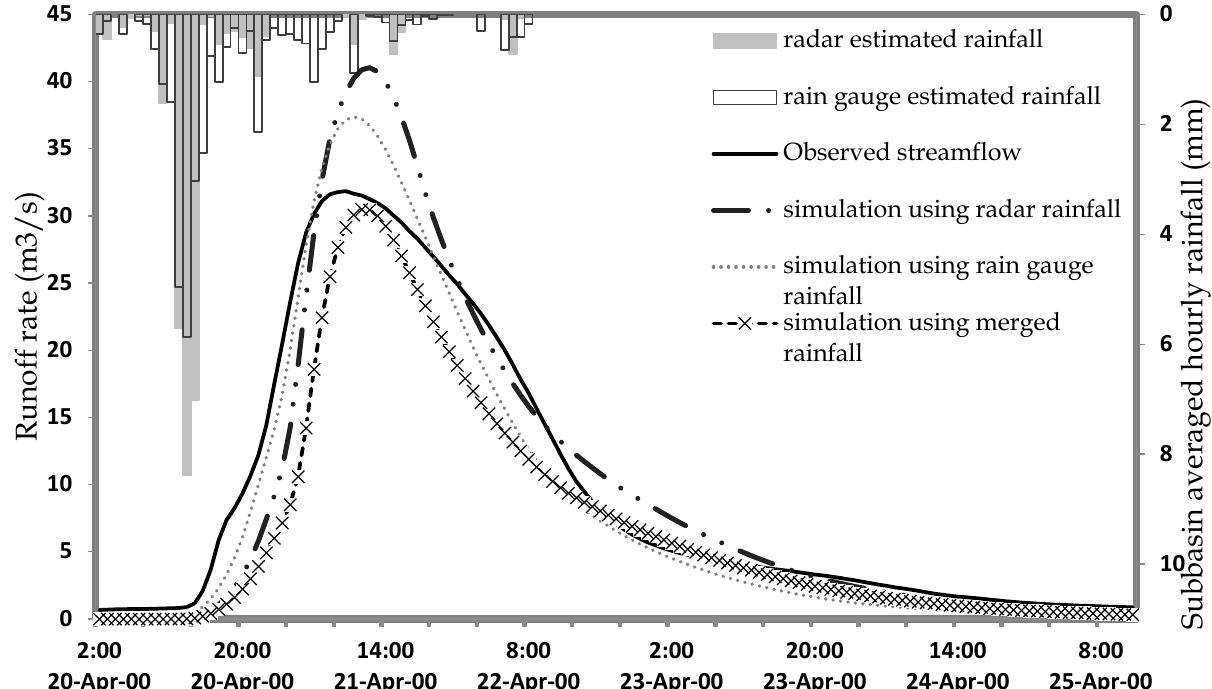
Figure 17. Comparison of estimated and observed hydrographs using different rainfall estimates for the 20 May 2004 event with SCS modeling option.